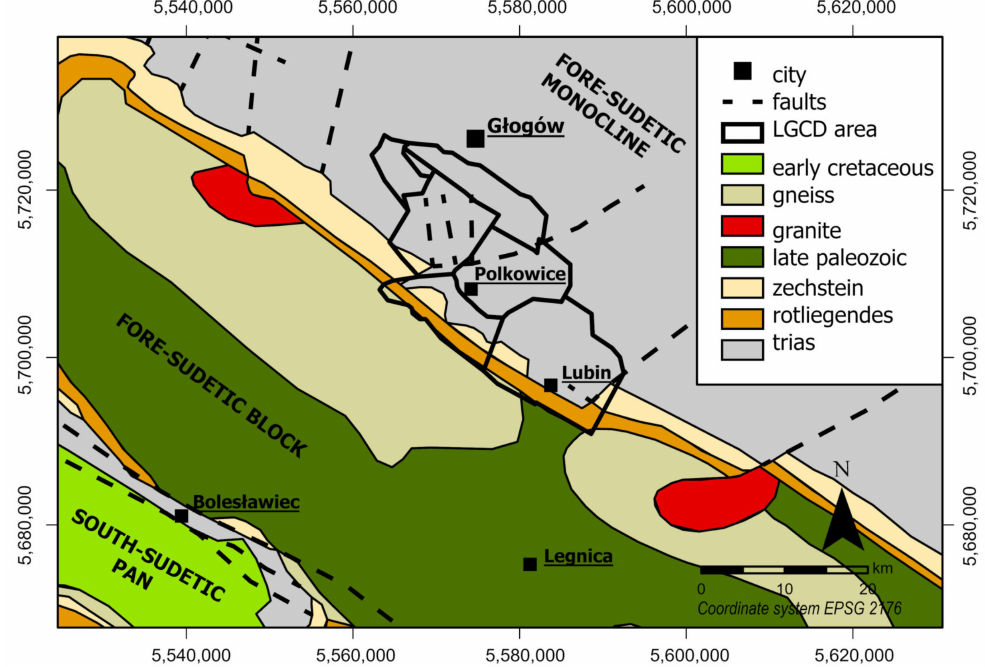
Figure 2. Geology of the Fore-Sudetic area. Figure based on